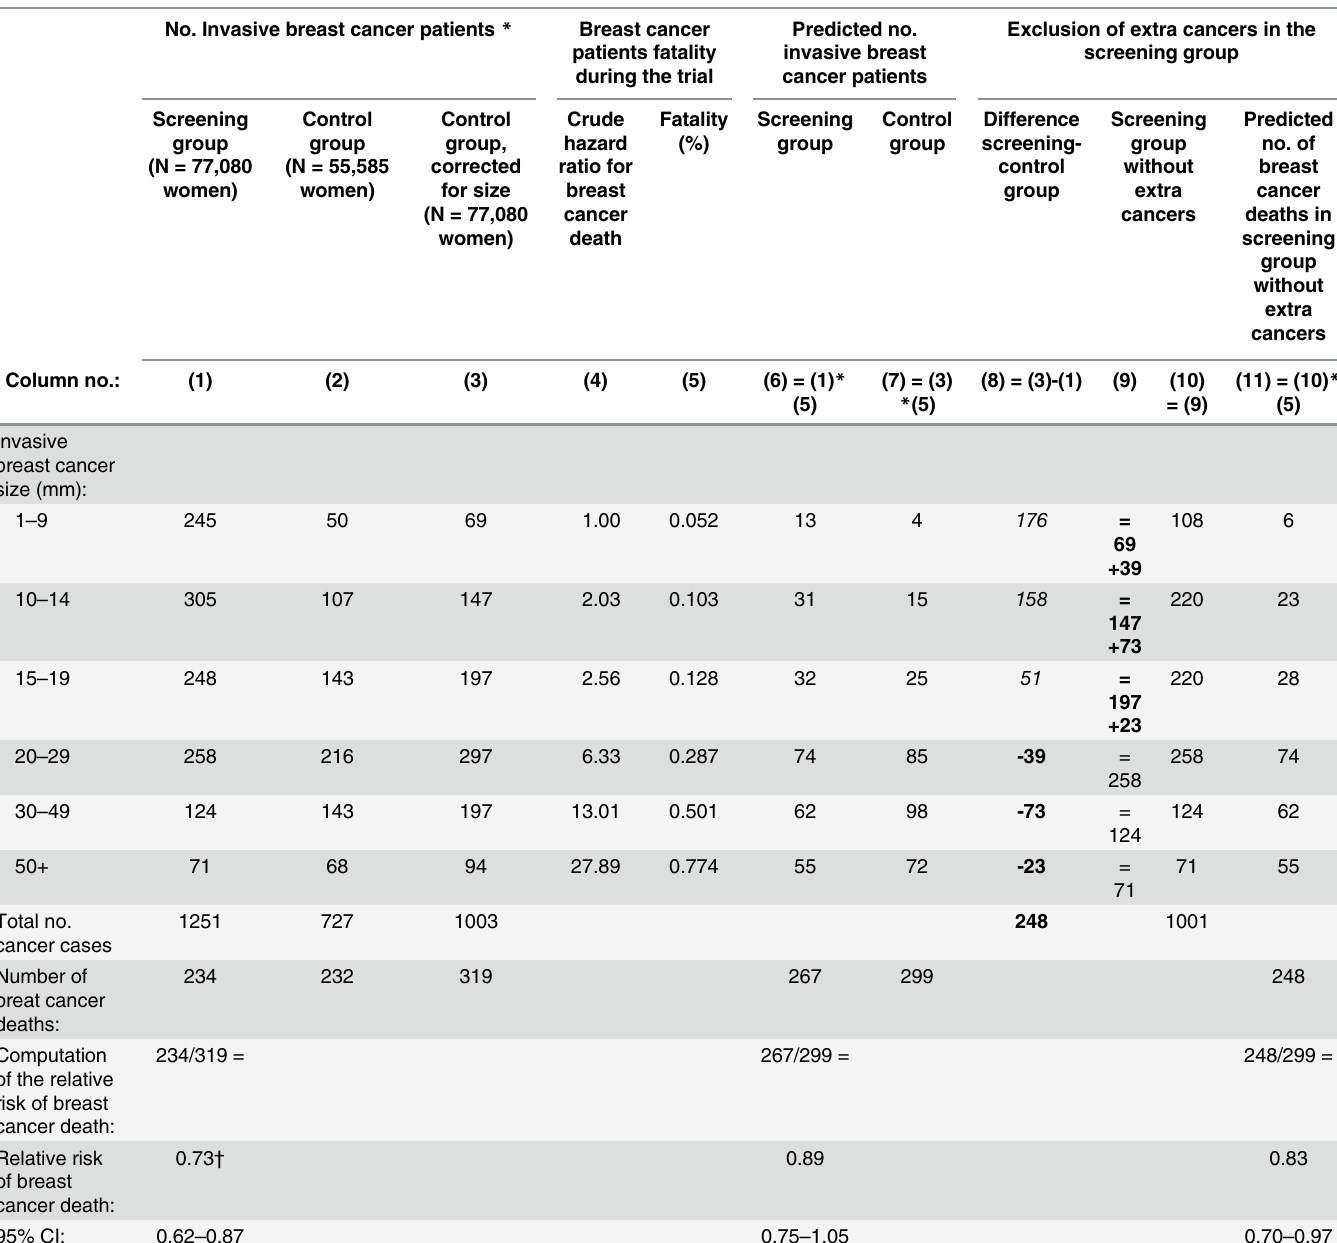
Table 4. Computations of predicted numbers of breast cancer deaths in the Two-County